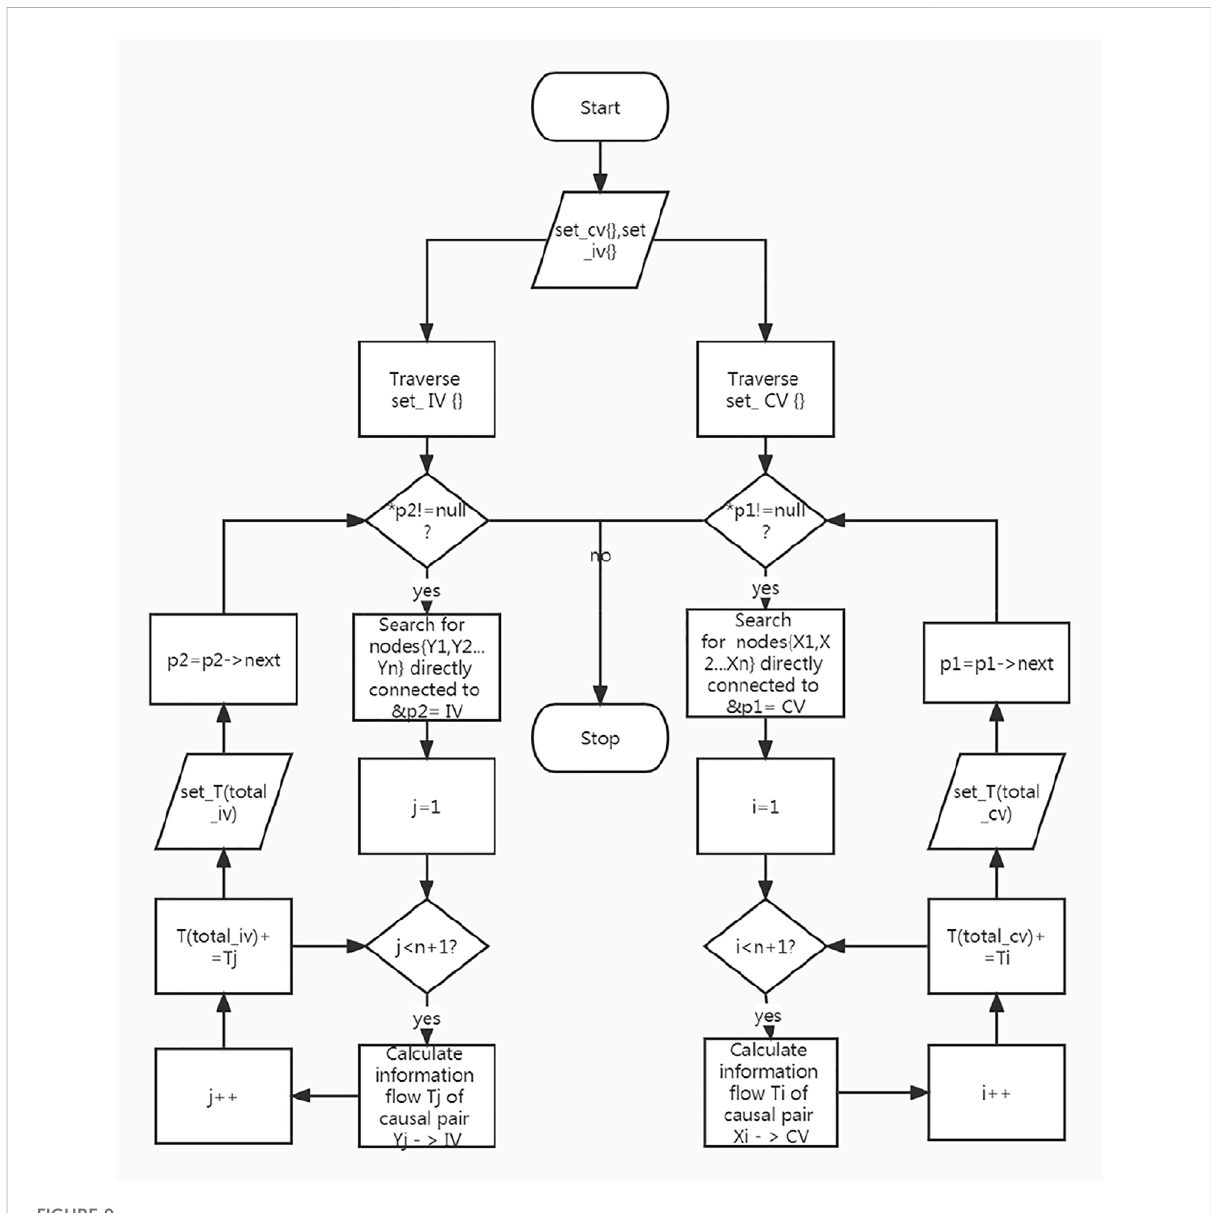
FIGURE 9 Flowchart of Algorithm